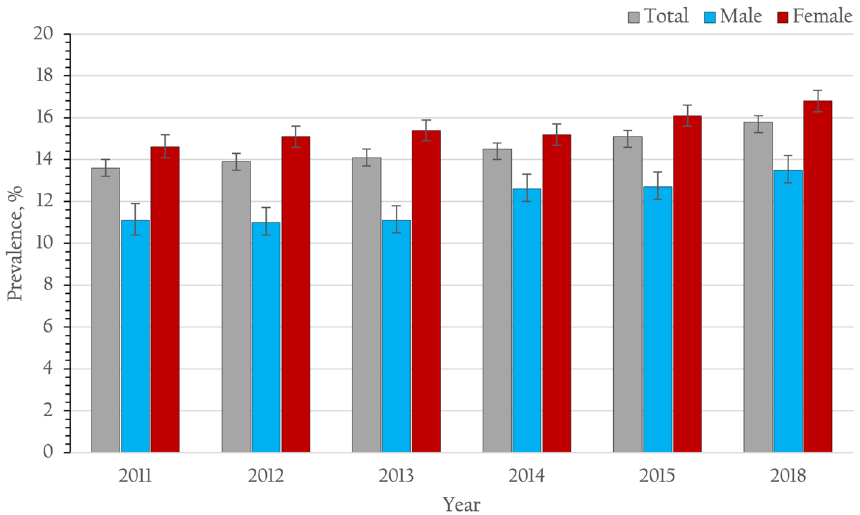
Figure 2. Prevalence of body mass index ≥ 30 kg/m 2 and 95% CI among patients with type 2 diabetes receiving continuous care in Thailand from 2011 to 2015 and 2018.